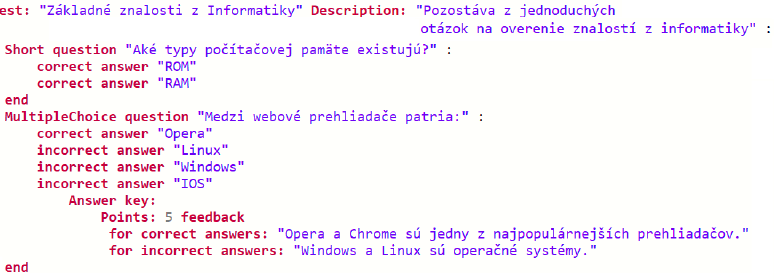
Figure 3. Example quiz in the Xtext-based editor.